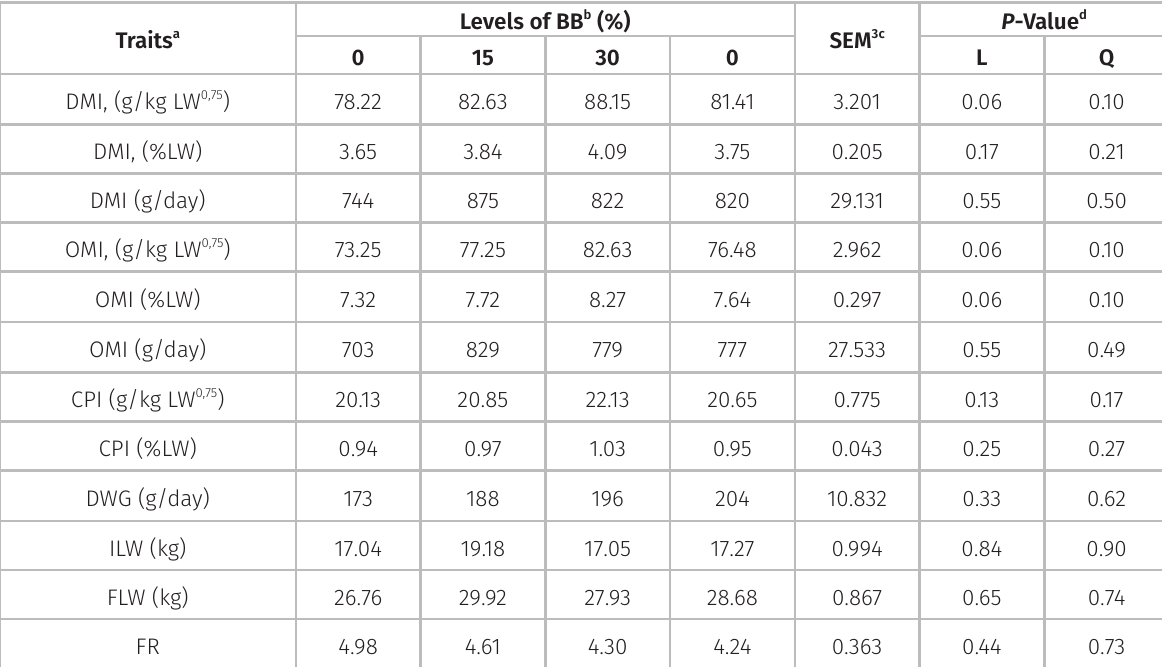
Table III. Dry matter and nutrient intake and performance lambs fed with biscuit bran (BB). Levels of BB b Traits a